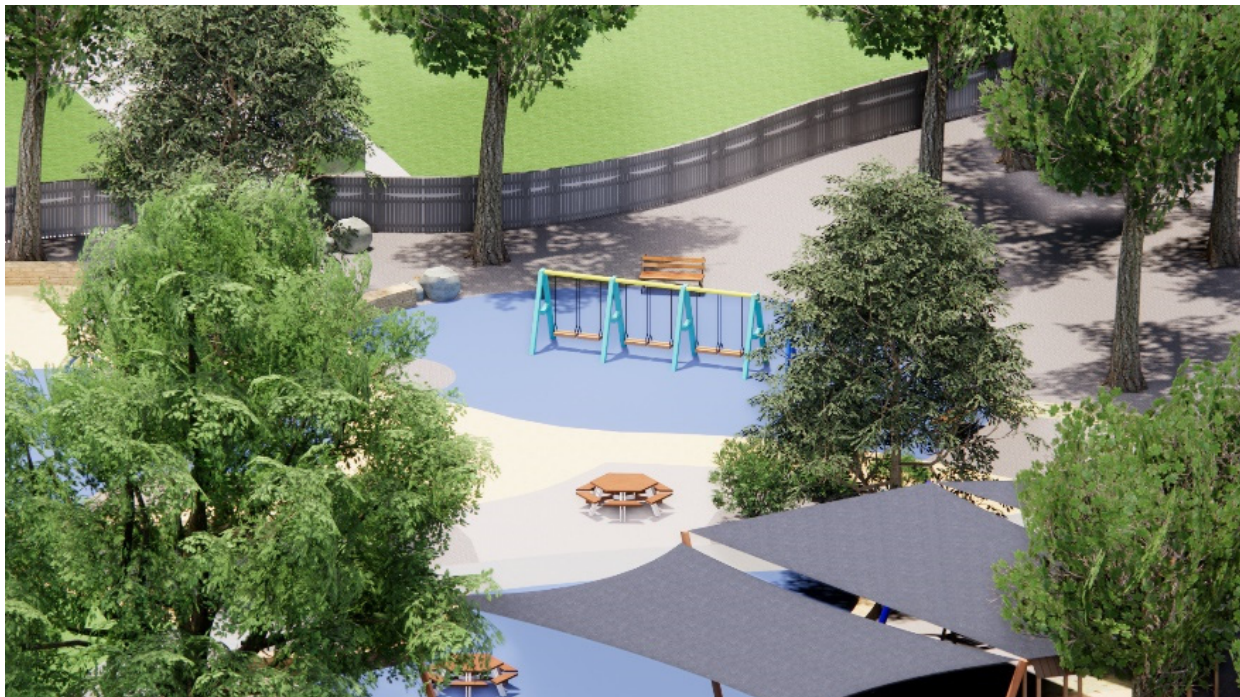
Figure 13. Shade sail, swings, and unshaded seating areas during midday on the summer solstice. Shadow Analysis simulations depicting the average number of hours (per day) in shade.